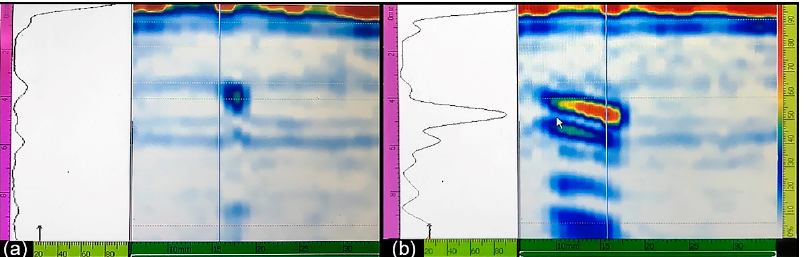
Figure 8. Screenshots from the Olympus OMNISCAN MX2 ultrasonic control box, using the Dual Linear Array 7.50L32-REX1-IHC probe, showing ( a ) the initial crack of approximately 0.5 mm length and ( b ) the same crack at the final stage with the transverse length of 10 mm.